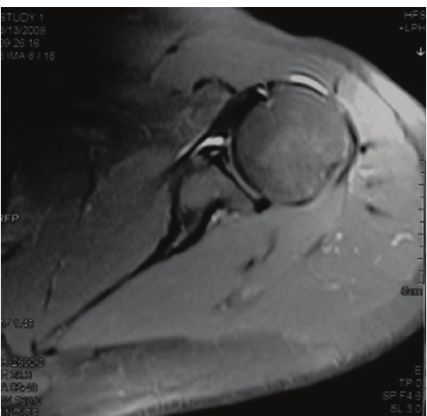
Figure 3: Perthes